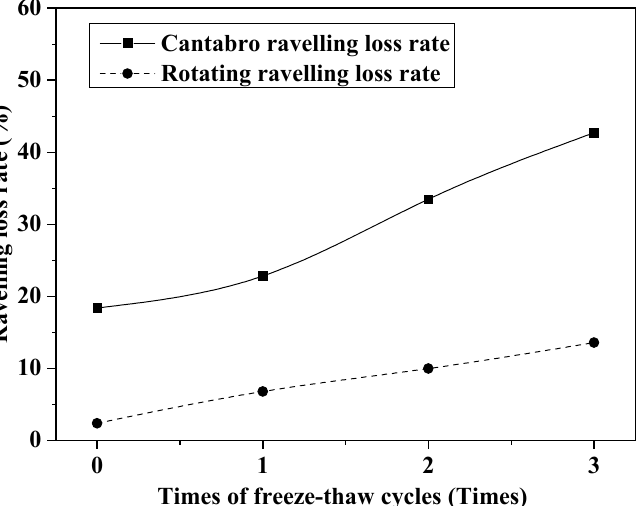
Figure 12. The results of the comparison between the two types of stripping tests under the influence of freeze–thaw cycle factors.